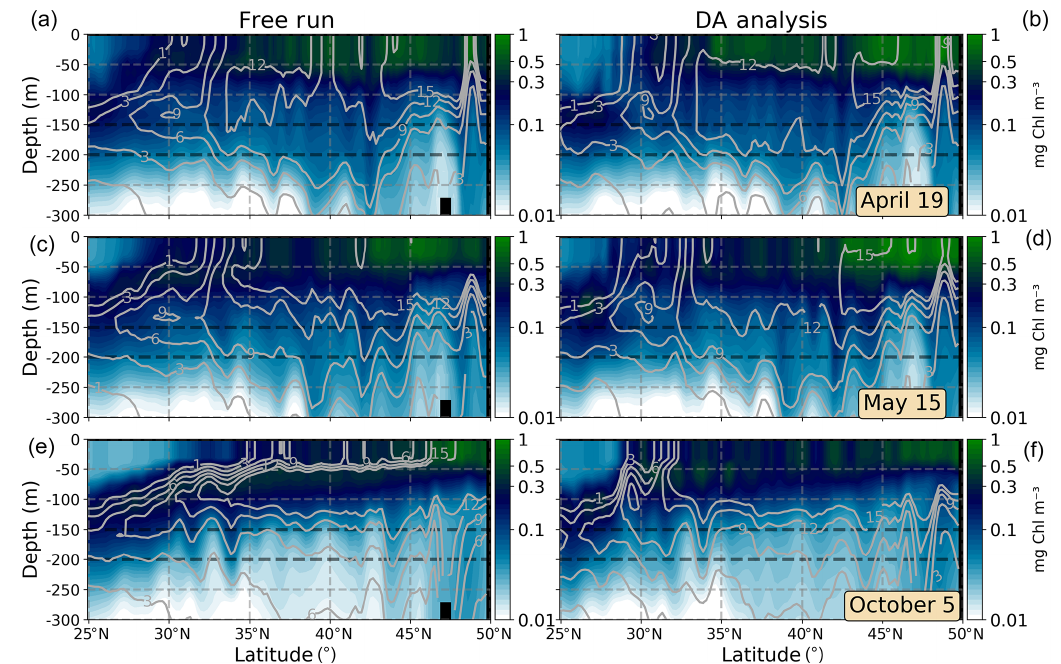
Figure 7. Meridional vertical sections (0–300m) of Chl a (mgChlm − 3 ) at 25 to 50 ◦ N, 45 ◦ W for 19 April, 15 May, and 5 October 2005. The ensemble median of the free run (a, c, e) and the assimilated (DA analysis; b, d, f ) simulations are represented. Nitrate + ammonium isolines (mmolNm − 3 ) are included as solid gray